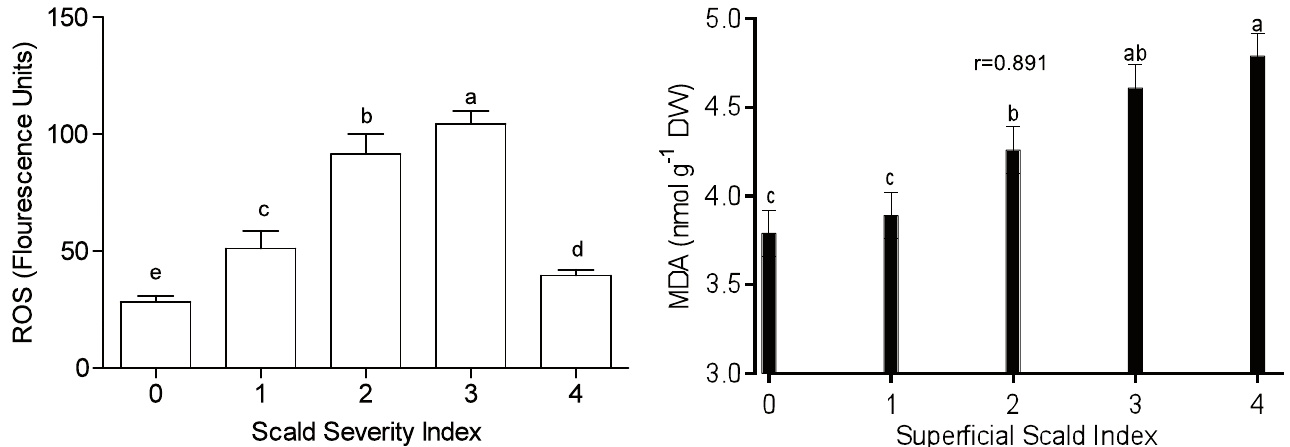
Fig. 3: Production of reactive oxygen species (ROS), as quantified by re- lative intensity of dichlorodihydrofluorescein diacetate (DCF) flu- orescence in peel slices of ‘Granny Smith’ apples with different scald severity. The data are the means ± standard error (SE) of six replicates with five fruits per replicate. Different letter(s) on the bars mean statistical differences according to Duncan’s multiple range test (p<0.05).